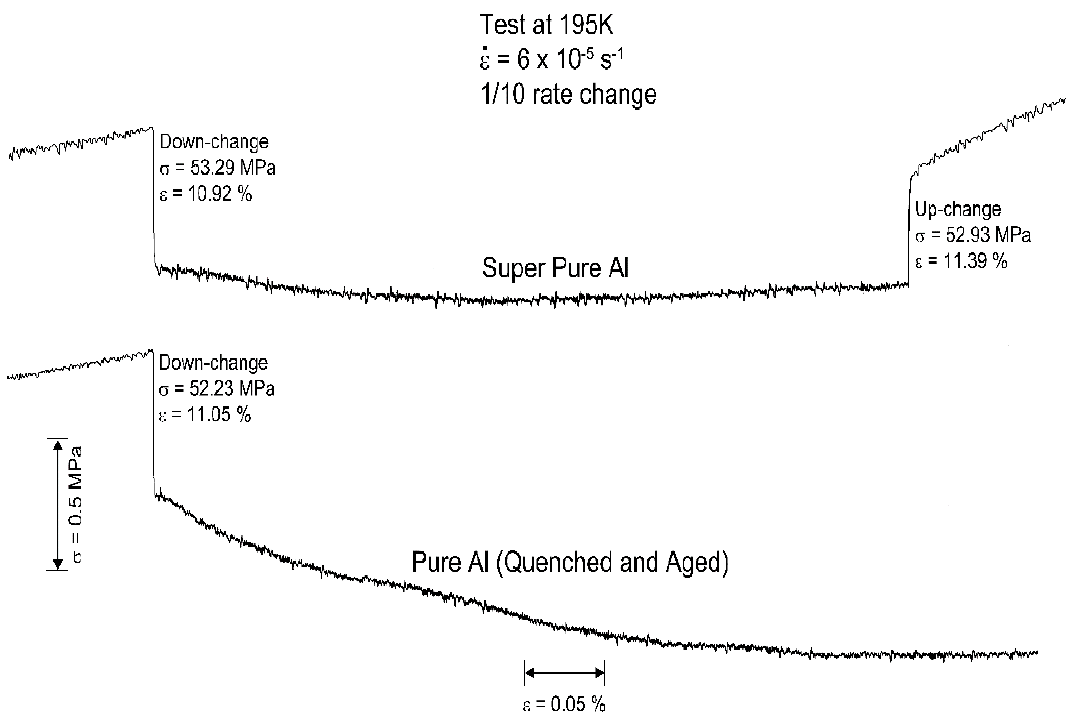
Figure 5. Comparison of load–displacement response of pure Al of similar large grain sizes but with one (bottom) containing nano-voids which manifests a decrease in flow stress [35]. The presence of nano-voids shows large initial recovery due to vacancy annihilation and a second stage due to image forces at a free surface which leads to work-softening [36].